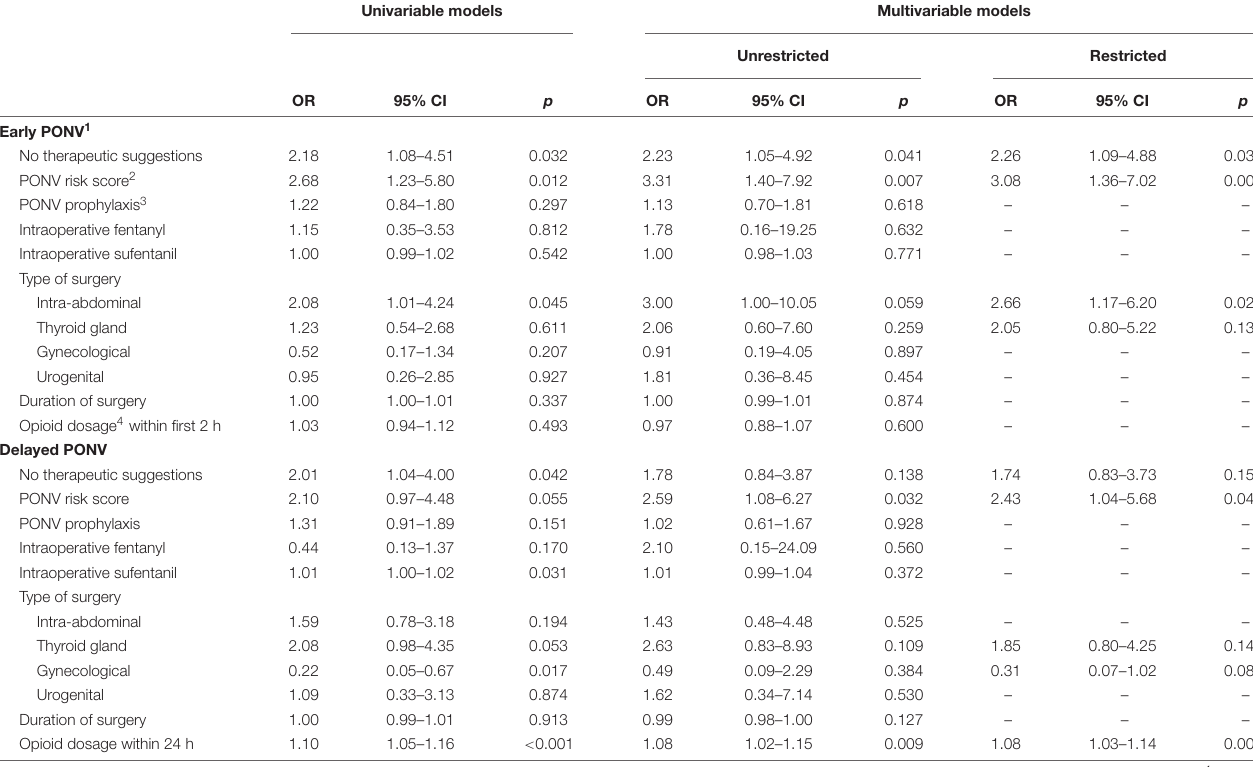
TABLE 4 | Logistic regression model for single and multiple predictors of postoperative nausea and vomiting in patients with high risk (Apfel score 3–4) ( n =